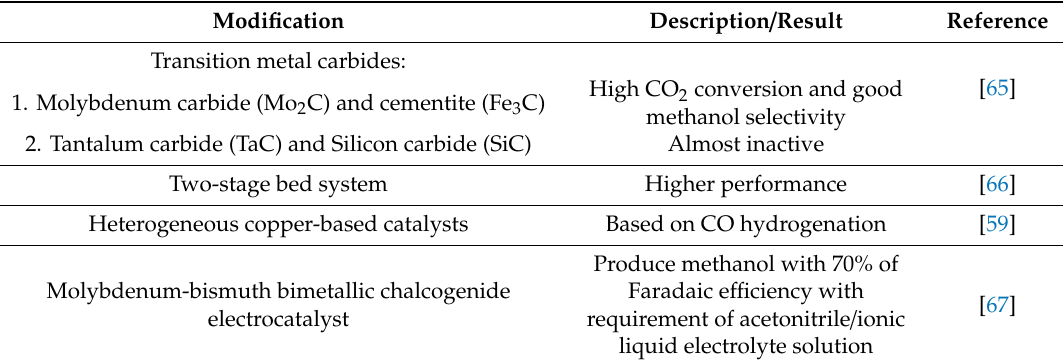
Table 2. Modification of direct hydrogenation of CO 2 to